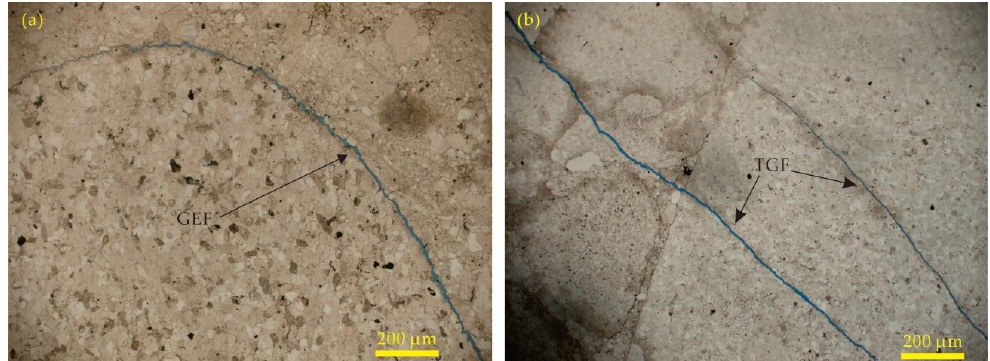
Figure 5. Gravel edge fracture (GEF) and trans-gravel fractures (TGF) in thin sections. ( a ) Gravel edge fracture (GEF), Well L104, 3175.05 m; ( b ) trans-gravel fractures (TGF), Well L16, 3159.34 m.